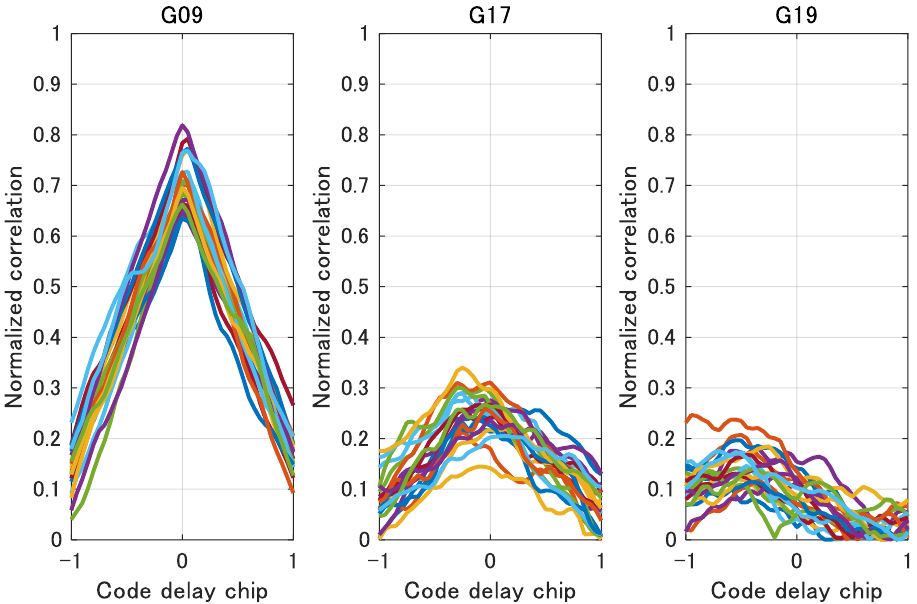
Figure 11. Examples of LOS and NLOS signal correlation outputs. 1 ms correlation outputs for a 20 ms period are overlapped in different colors. The left figure SHOWS the correlation outputs of LOS satellites, and the two figures on the right show the correlation outputs of NLOS